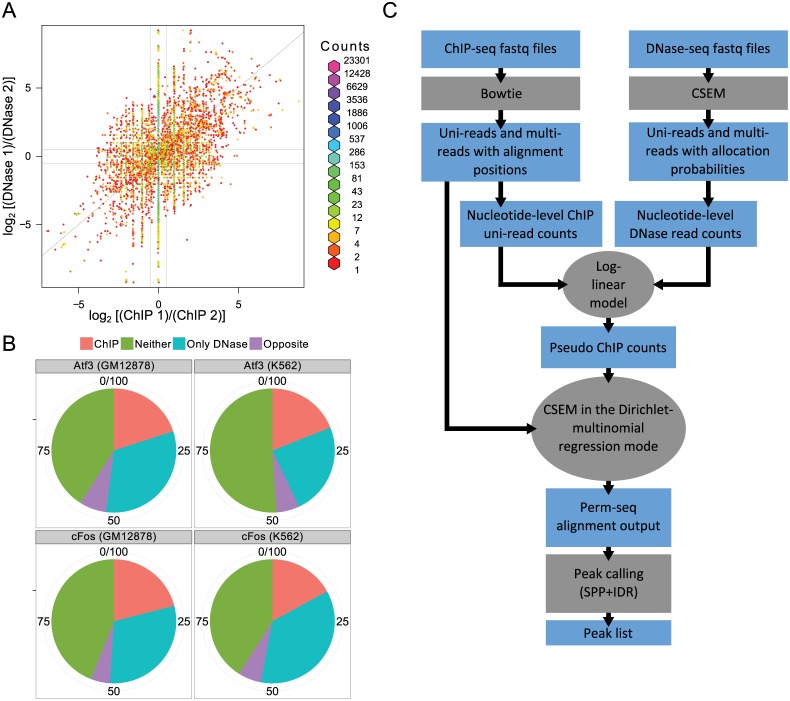
Discriminative power of DNase-seq for mapping locations of multi-reads.(a) Log base two ratios of DNase-seq versus ChIP-seq read counts in the local neighbourhoods of the two mapping locations of each multi-read in Gata2 ChIP-seq dataset (Huvec). The vertical and horizontal lines depict boundaries with the log base two ratios equal to 0.5. The proportion of read pairs in categories: ChIP: ChIP or both ChIP and DNase discriminates; Neither: Neither ChIP nor DNase discriminates; Only DNase: Only DNase discriminates; Opposite: ChIP and DNase log base 2 ratios have different signs are 23%, 44%, 26%, and 7%, respectively. (b) Classification of multi-reads with two mapping locations based on their local DNase-seq and ChIP-seq read counts into 4 groups as ChIP, Neither, Only DNase, and Opposite. (c) Overall summary of the Perm-seq pipeline.